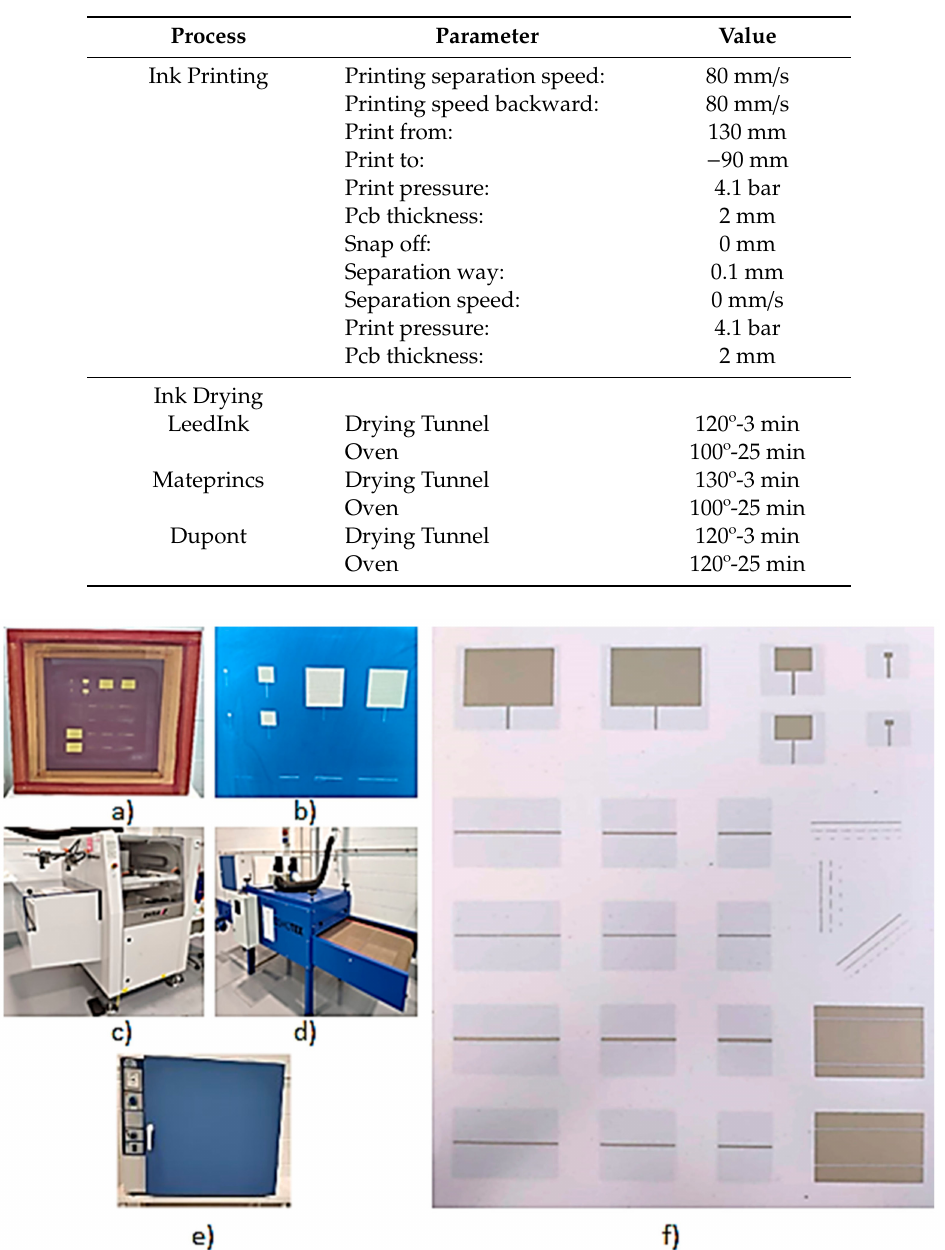
Table 1. Screen-printing process parameters.